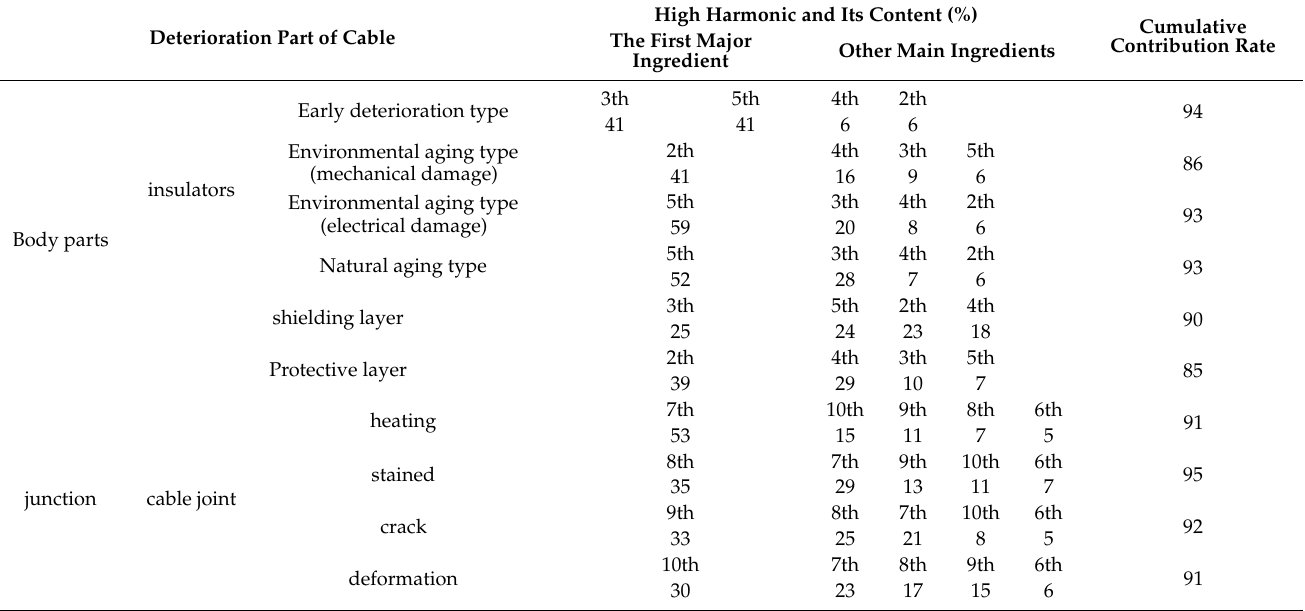
Table 1. The relationship between cable aging position and higher